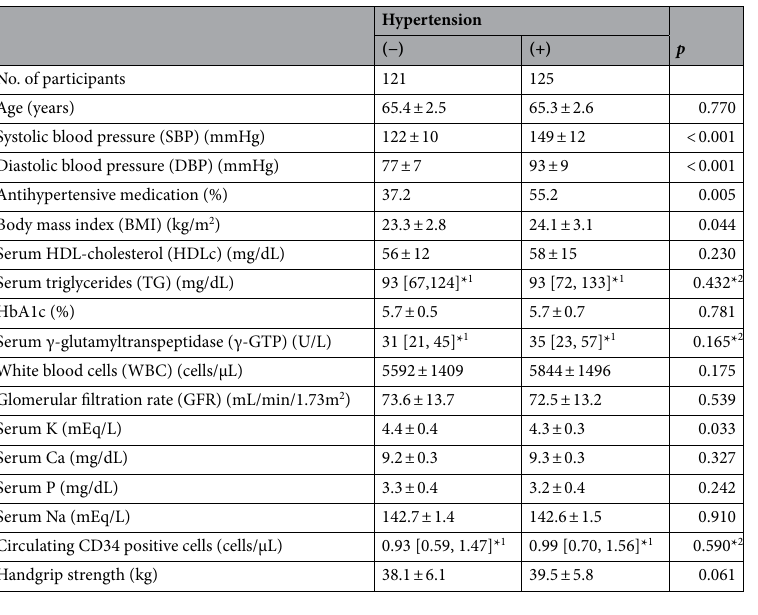
Table 1. Characteristics of study population according to hypertension status. Values: mean ± standard deviation. *1: Values are median [first quartile, third quartile]. Regression model for mean values was used for determining p values. *2: Logarithmic transformation was used for evaluating